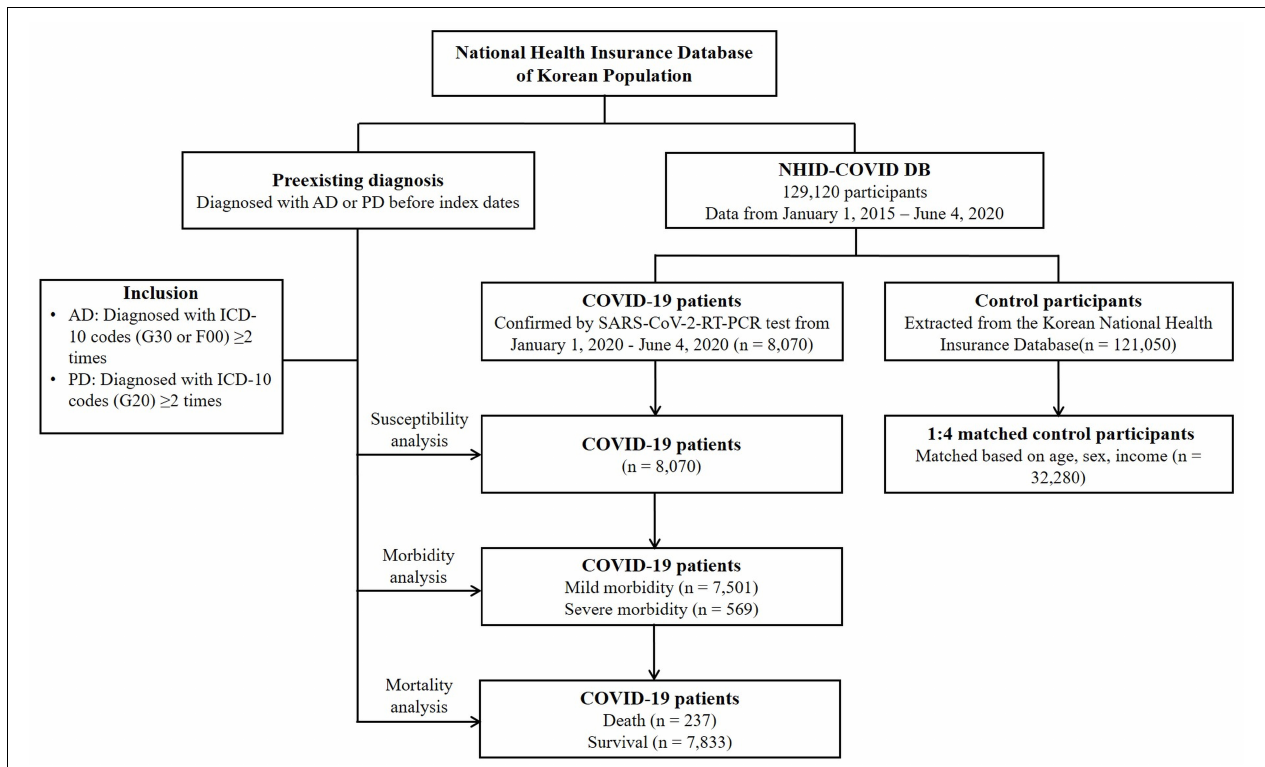
FIGURE 1 | A flowchart of the screening process used in this study. From a total of 129,120 participants, 8,070 COVID-19 patients were matched for age, sex, and income with 32,280 control participants. AD, Alzheimer’s disease; ICD-10, International Classification of Diseases, Tenth Revision; NHID-COVID DB, National Health Insurance Database Coronavirus disease 2019; PD, Parkinson’s disease; RT-PCR, reverse-transcriptase-polymerase chain reaction.